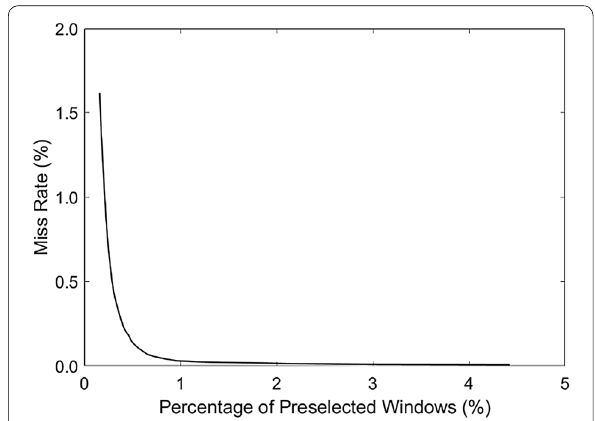
Fig. 5 Miss rate of the HOG features based SVM when preselecting windows for